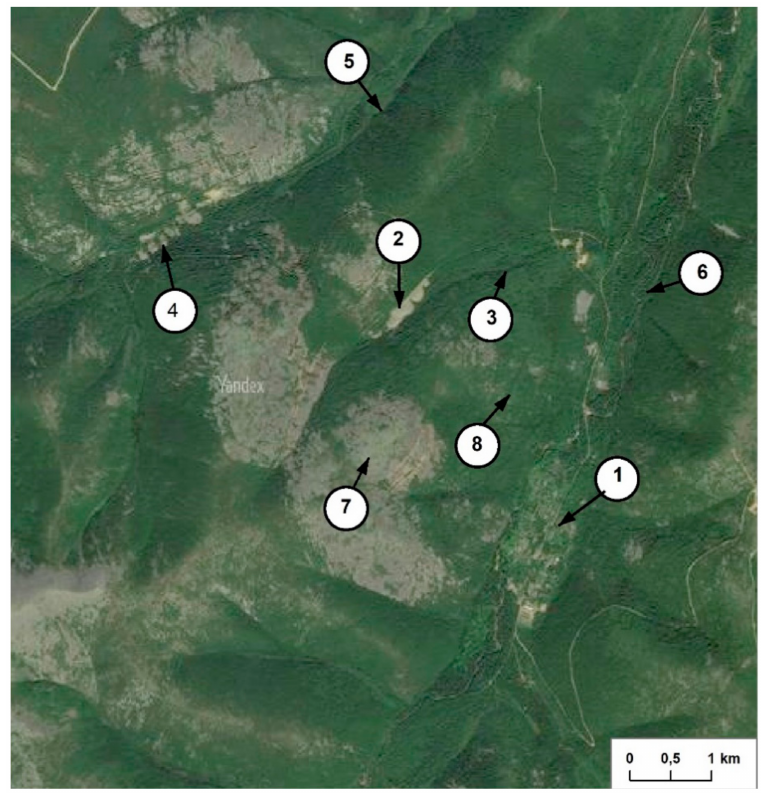
Figure 3. Satellite image of the study area: 1—Zarechny village; 2—Kurung site; 3—Propadayushiy Creek; 4—Akin site; 5—Akin Creek; 6—Kurung River; 7—tundra mountain tops and stony heaths; 8—watershed slopes with mountain–taiga